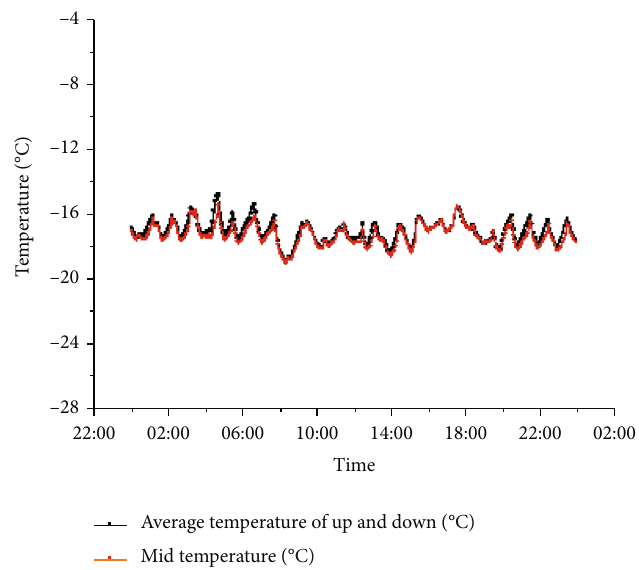
Figure 3: Average temperature and midtemperature of measuring points at vertical position 3.